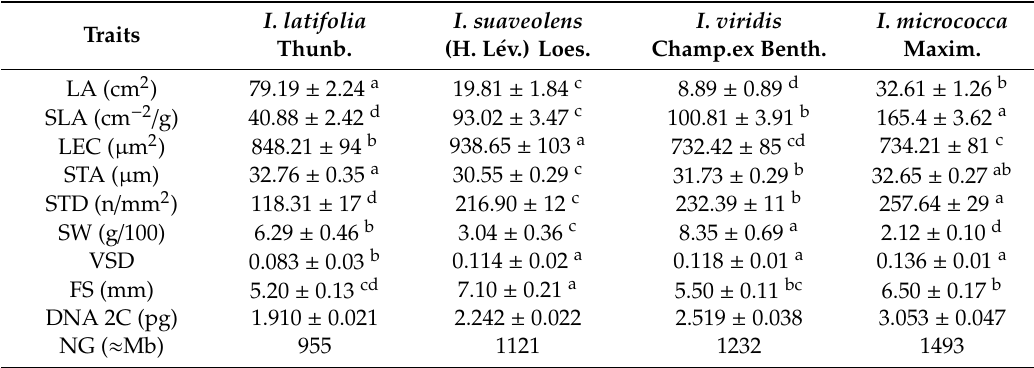
Table 1. Comparison of the morphological traits between four subtropical Ilex species. Traits